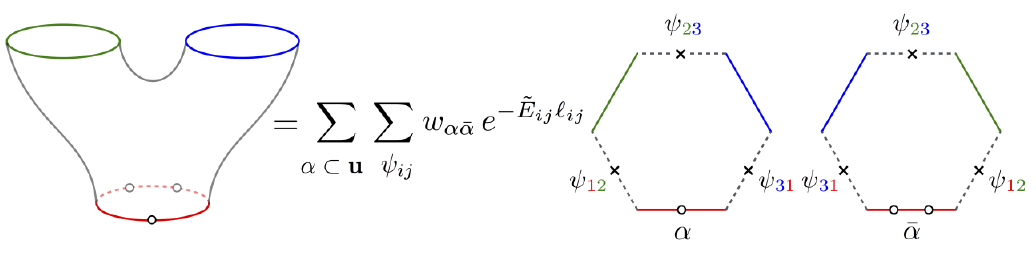
Figure 2 . As we cut the pair of pants in two hexagons, we must partition the Bethe roots u into the sets (cid:11) and (cid:22) (cid:11) which populate the physical edge of each of the hexagon form factors. Finite-size corrections are obtained by inserting particle/anti-particle pairs in the mirror edges of the hexagons, denoted here by ij